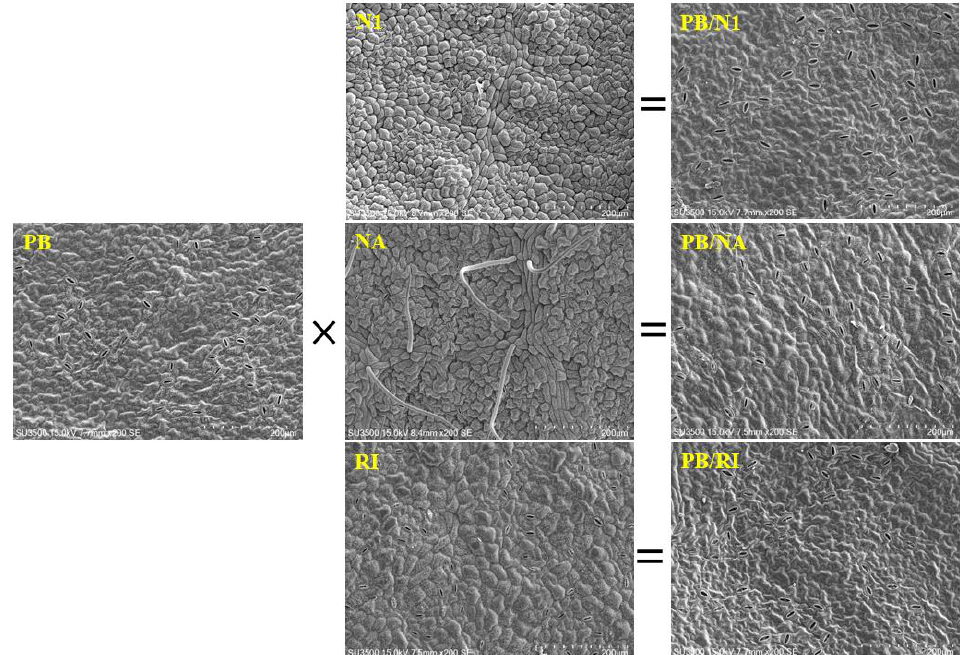
Figure 6. Stomatal images of one scion, three rootstocks, and three grafted plants taken with scanning electron microscopy in summer. (PB): scion cut rose of Rosa hybrida cv. Pink Beauty; (N1): rootstock of Rosa multiflora cv. Hort No 1; (NA): rootstock of Rosa canina cv. Natal brier; (RI): rootstock of Rosa indica cv. Major; (PB/N1): PB grafted onto N1; (PB/NA): PB grafted onto NA; (PB/RI): PB grafted onto RI.